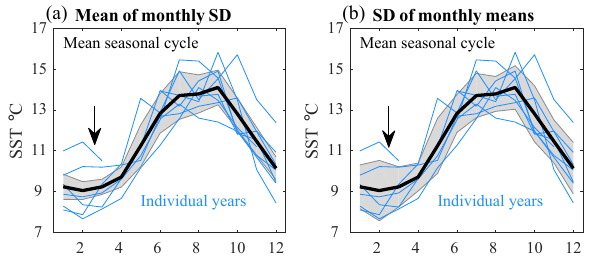
Figure 3. Monthly averaged SST values for each year (2006–2015) of Cape Elizabeth mooring data (mm yr ; blue lines) and the aver- age seasonal cycle of SST across all deployments (mm; black line). Blue and black lines are the same in plots (a) and (b) . Gray shad- ing represents (a) the mean monthly standard deviation ( ¯ m σ ) and (b) the standard deviation of monthly means ( σ ). Black arrows point to a region of notable discrepancy between computations. Here, the average sub-monthly SST variability (a) is much smaller than the range of interannual SST variability (b) , indicating that organ- isms could experience distinct (i.e., non-overlapping) SST condi- tions during two subsequent